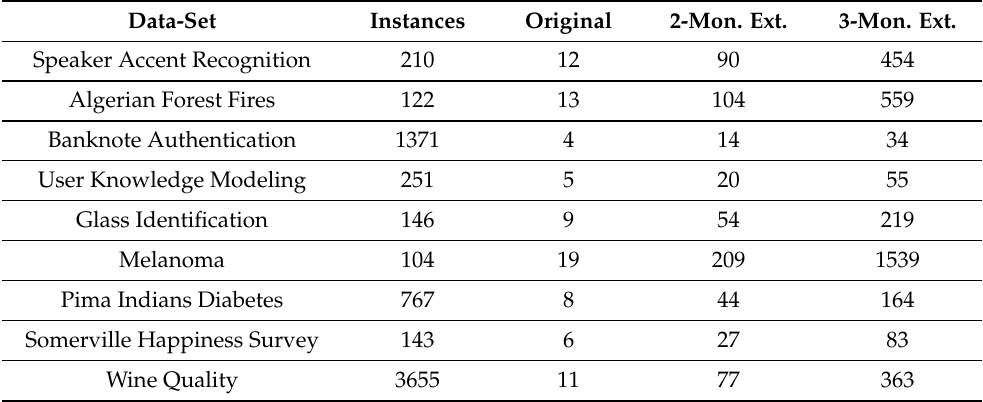
Table A1. Basic information about the real datasets. The column “Instances” denotes the number of entries in the dataset. The column “Original” denotes the number of features in the original dataset. The columns “2-Mon. Ext.” and “3-Mon. Ext.” denote the number of features in the 2-monomial extension and 3-monomial extension, respectively.